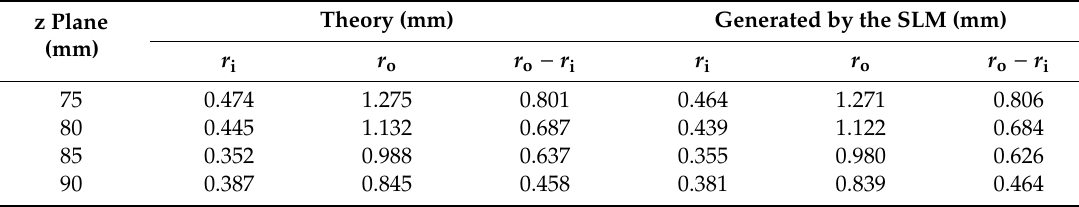
Figure 10. The experimental results for the simulating negative axicon with the SLM, ( a ) z = 75 mm, ( b ) z = 80 mm, ( c ) z = 85 mm, ( d ) z = 90 mm. Table 2. Radii of the annular beam of theory and generated by the